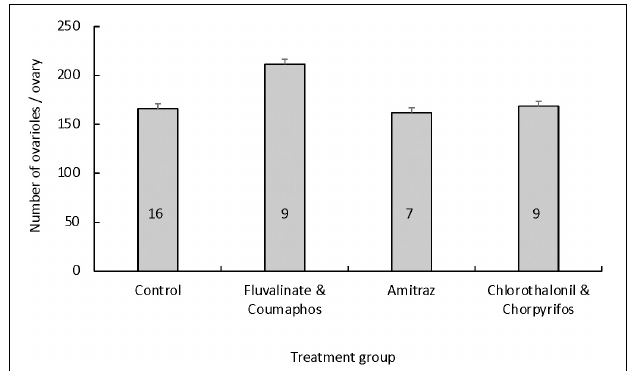
FIGURE 4 | Mean ( ± S.E.M.) number of ovarioles per queen ovary based on the queen’s rearing environment. Queen larvae were reared in cups coated with wax that was pesticide-free (control group) or contaminated with either (a) a combination of tau -fluvalinate and coumaphos, (b) amitraz alone or (c) a combination of chlorothalonil and chlorpyrifos. The number of queens used per treatment group is given inside each bar. There was no difference in the number of ovarioles per queen ovary based on the treatment group [ANOVA: F ( 3 , 40 ) = 0.88, p =